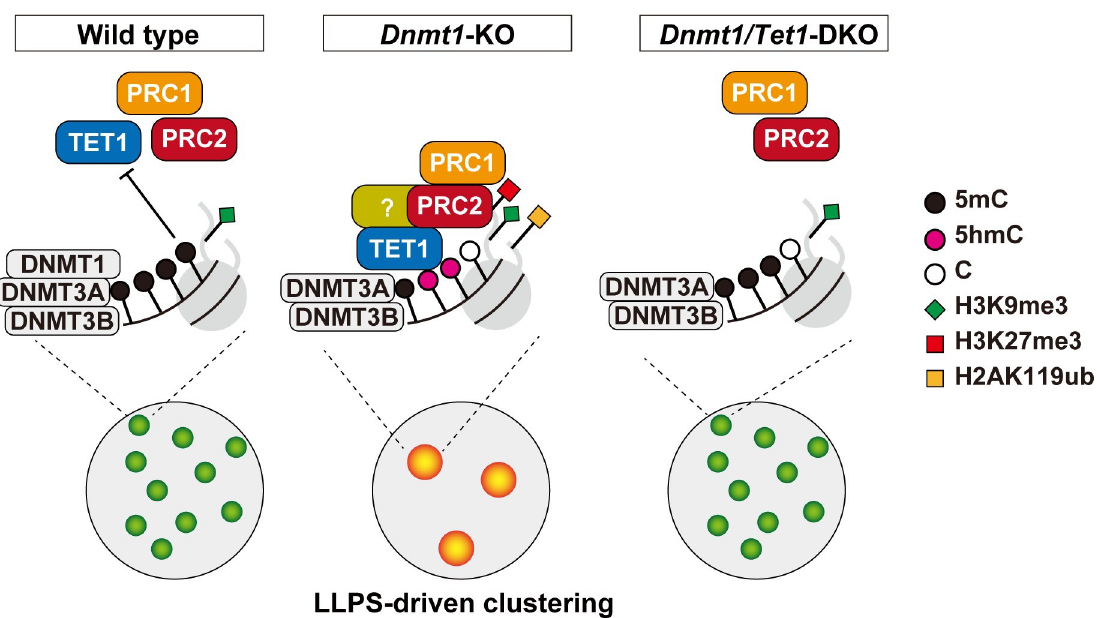
Fig 5. A model of Tet1 -mediated chromocenter clustering in DNA hypomethylated cells. CpG sites in the PCH were highly methylated by DNMTs and not accessible by TET1 and PcG proteins in the wild-type ESCs (Left panel). DNA hypomethylated condition allows TET1 to bind PCH region and TET1 recruits PcG proteins in the Dnmt 1-KO ESCs. Thus, 5hmC, H2AK119ub, and H3K27me3 are enriched in PCH, and the chromocenters are clustered through the LLPS mechanism (Middle panel). PcG proteins are not recruited to PCH and chromocenters remain dispersed in the Dnmt1/Tet1 -KO ESCs (Right